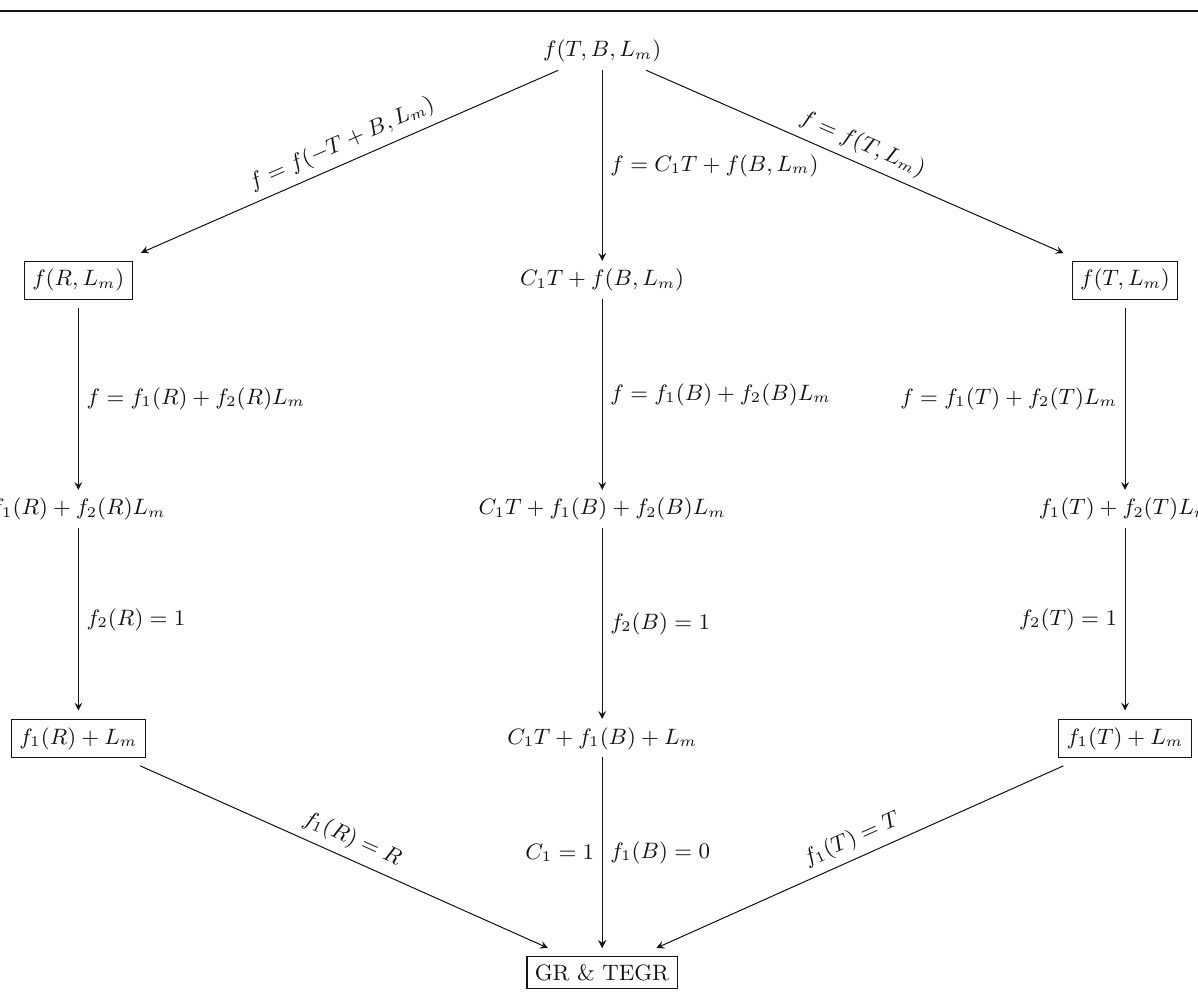
ond derivatives of the scale factor, exactly as B , so it is not so strange to see that the dimensionality of the dynam- ical system of f ( R , L m ) is the same as C 1 T + f ( B , L m ) . Under the boundary-matter coupled model, we have stud- ied a specific case where the matter Lagrangian is non- minimally coupled with B as f 1 ( B ) + f 2 ( B ) L m . By assum- ing some power-law boundary functions f 1 ( B ) = C 5 B s and f 2 ( B ) = ( C 4 + C 3 B q ) , we analysed the dynamics using dynamical system techniques. In general, the dynamical sys- tem for this power-law couplings are four dimensional but for the specific case where q = 1 − s , becomes a three dimen- sional one. Thus, we have analysed this model depending on three different limit cases: (i) q = 1, (ii) C 5 = 0 and lastly the case (iii) C 5 (cid:10)= 0 , q = 1 − s . In general, the dynamics of all of these models are similar. As we have seen, mainly only one critical point is obtained for mainly all of them. The sta- bility of those points were also studied, showing the regions where the critical points become